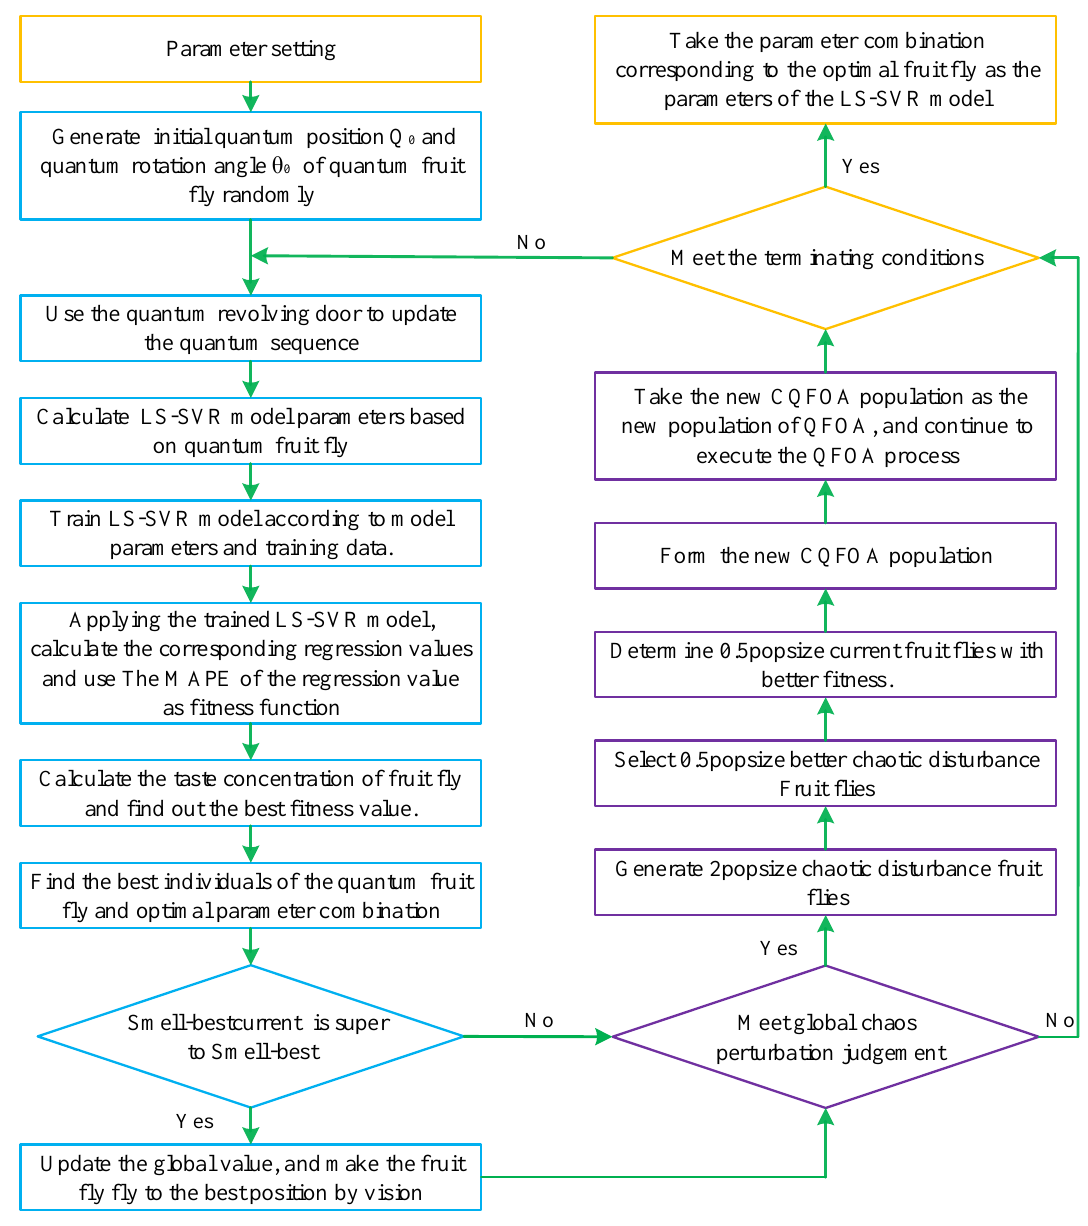
Figure 1. Chaotic quantum FOA algorithm flowchart .